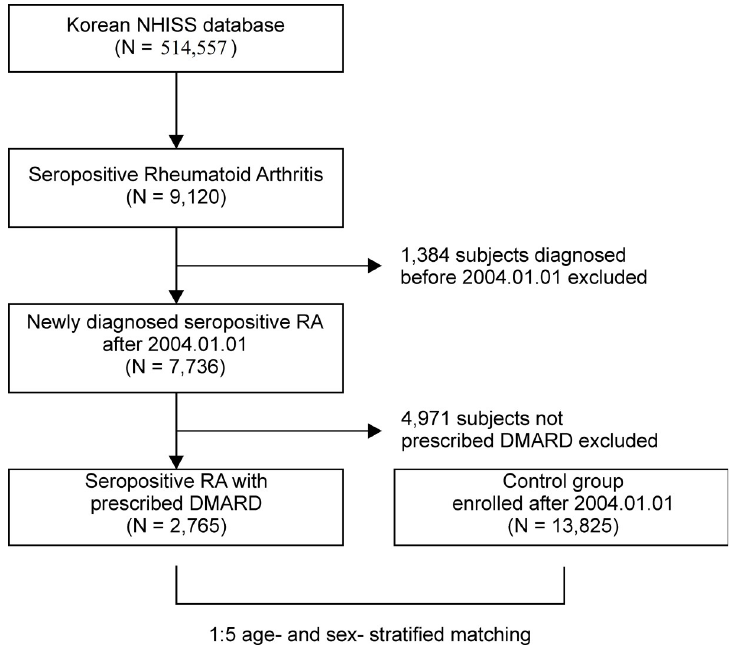
Fig 1. Cohort creation flow diagram. This study was a 12-year longitudinal cohort study established from the NHIS-HEALS cohort.